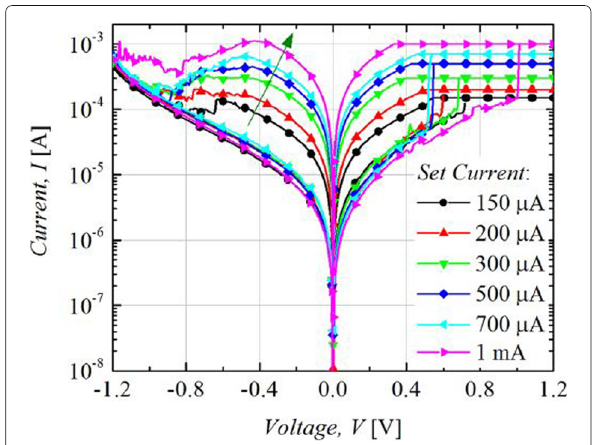
Fig. 11 Multilevel characteristics of Ti/Ta 2 O 5 /Pt RRAM obtained by controlling the compliance current. ‘Reproduced from [127], with the permission of AIP